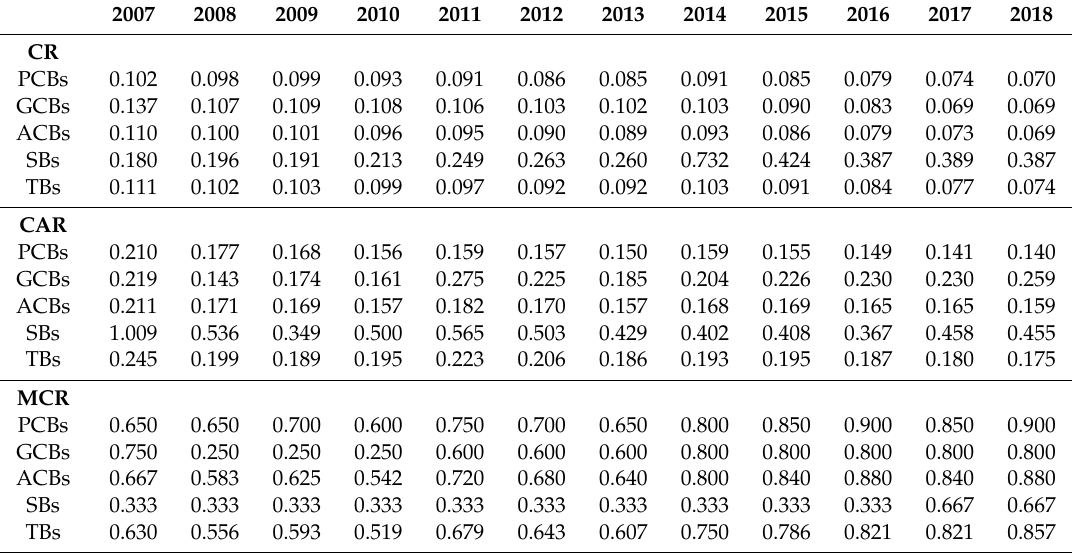
Table 3. Comparative trend analysis of